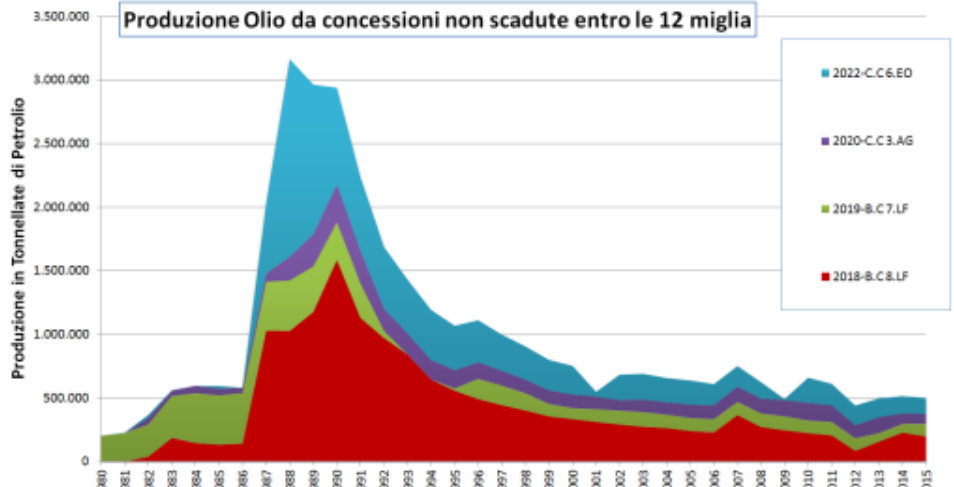
Figure 3. Oil production from concessions still valid for drilling offshore within the 12 mile zone (on the right, expiration year shown for each license). The concessions are ordered from bottom to upper side according to the order of termination period. Four drilling licenses extract oil with a constant production rate that seems capable of continuing the trend in the next years. X axis: year of report. Y axis: oil amounts in tons